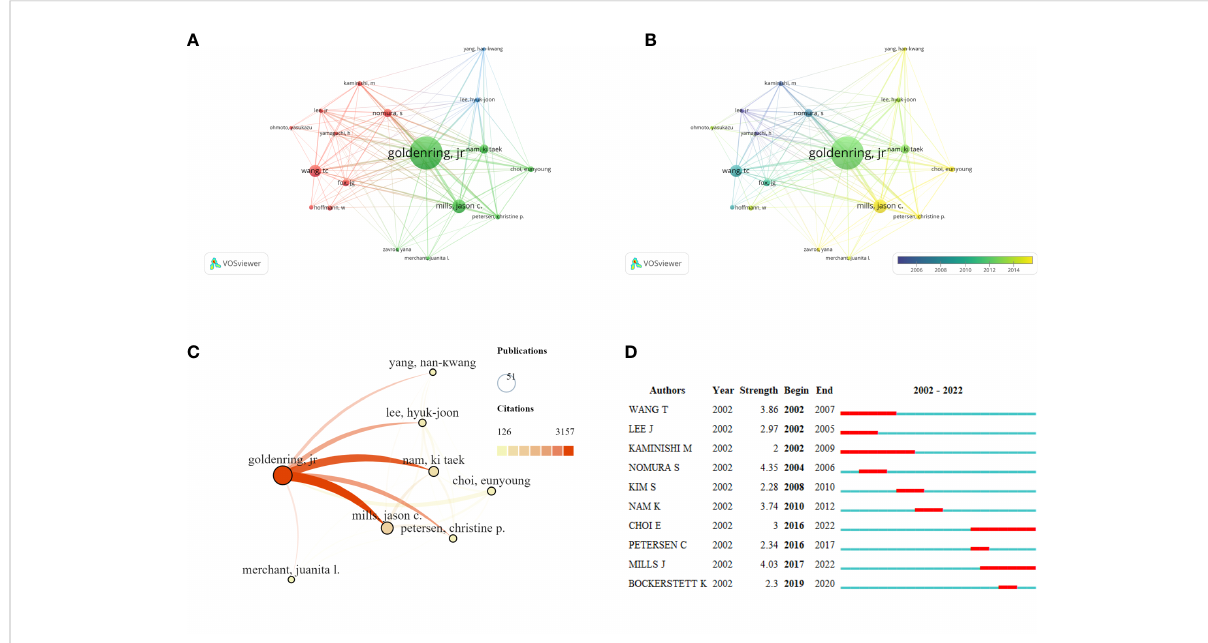
FIGURE 3 Co-occurrence analysis of active authors and their contributions. The network visualization map (A) and overlay visualization map (B) of the core co-authorship analysis generated by VOSviewer. The minimum number of documents of an author is ≥ 6. (C) The visualization map of